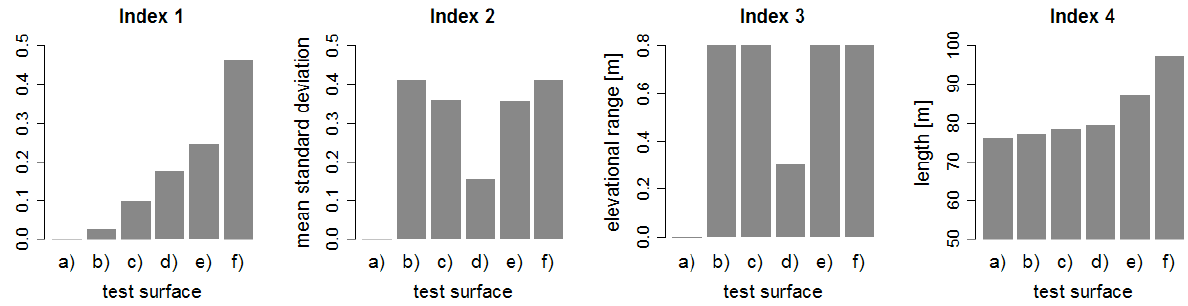
Figure 3. Performance of different indices of relief heterogeneity on the test-surfaces presented in Figure 2. “Index 1”: Mean four point moving window standard deviation. “Index 2”: Mean transect wise standard deviation. “Index 3”: range of all measured elevations. “Index 4”: transect wise